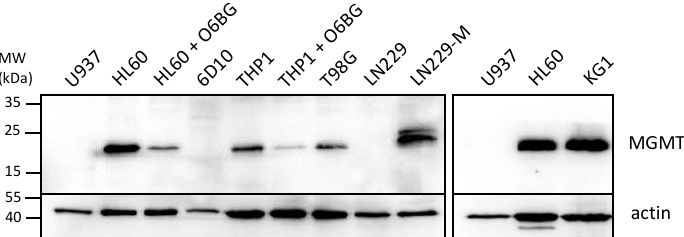
Figure 2. AML cells express different levels of MGMT. Cells grown in log phase were harvested and cell lysates were analyzed by Western blot analysis with an antibody specific for MGMT. Actin was used as the loading control. The following controls were included to ascertain specificity of the MGMT antibody: (i) HL60 and THP1 cells were treated for 18 h with 15 µM O6BG, an MGMT inhibitor known to down-regulate MGMT protein levels; (ii) T98G are glioblastoma cells known to be positive for MGMT expression; (iii) LN229 are glioblastoma cells known to be negative for MGMT, and LN229-M are a subline infected with a construct expressing MGMT cDNA [44]. Original blots see File S1.